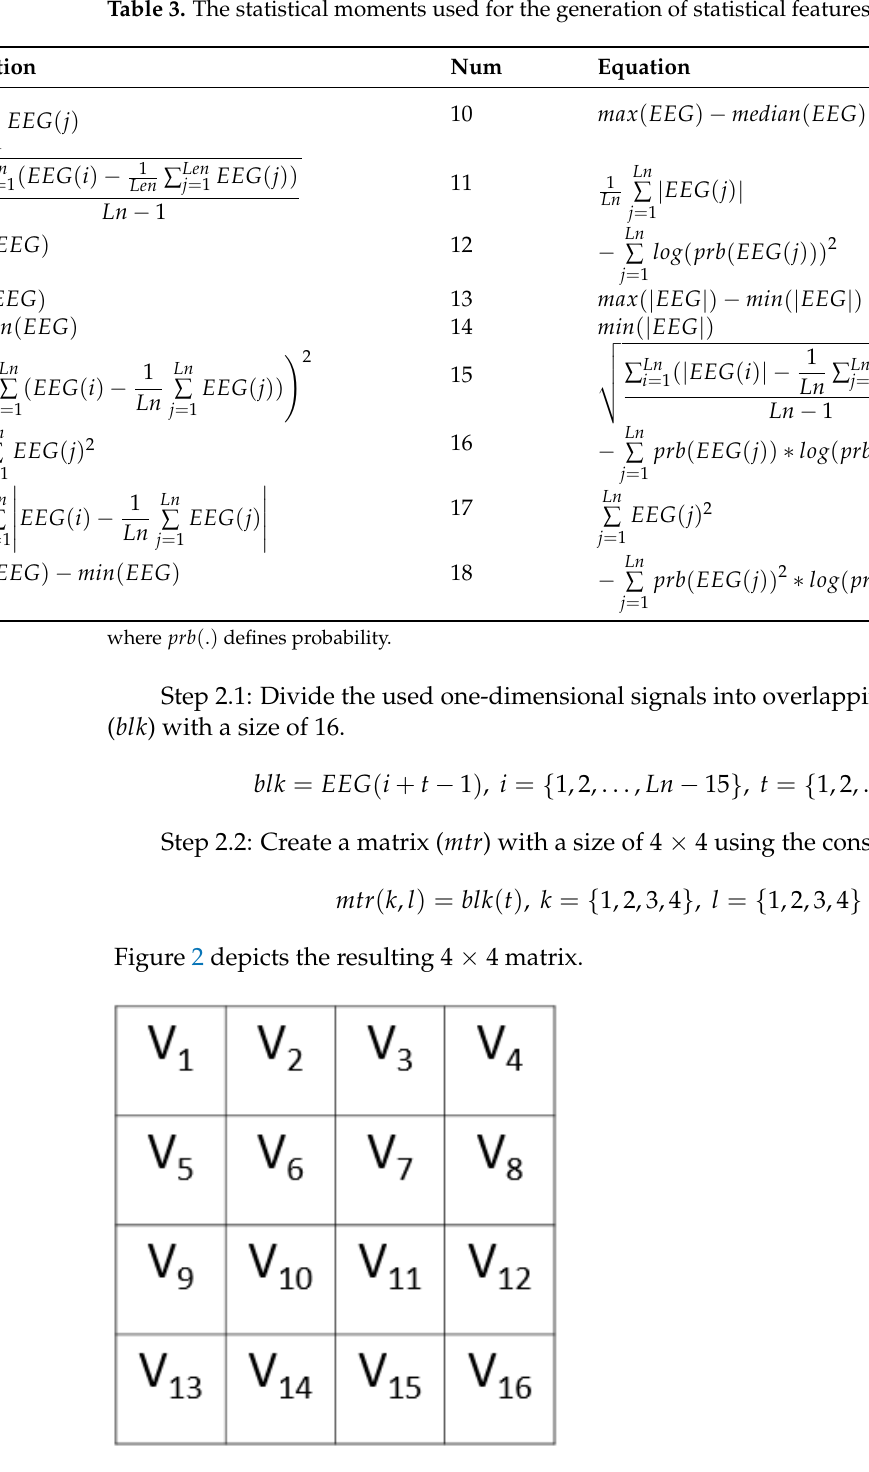
Table 3. The statistical moments used for the generation of statistical features.